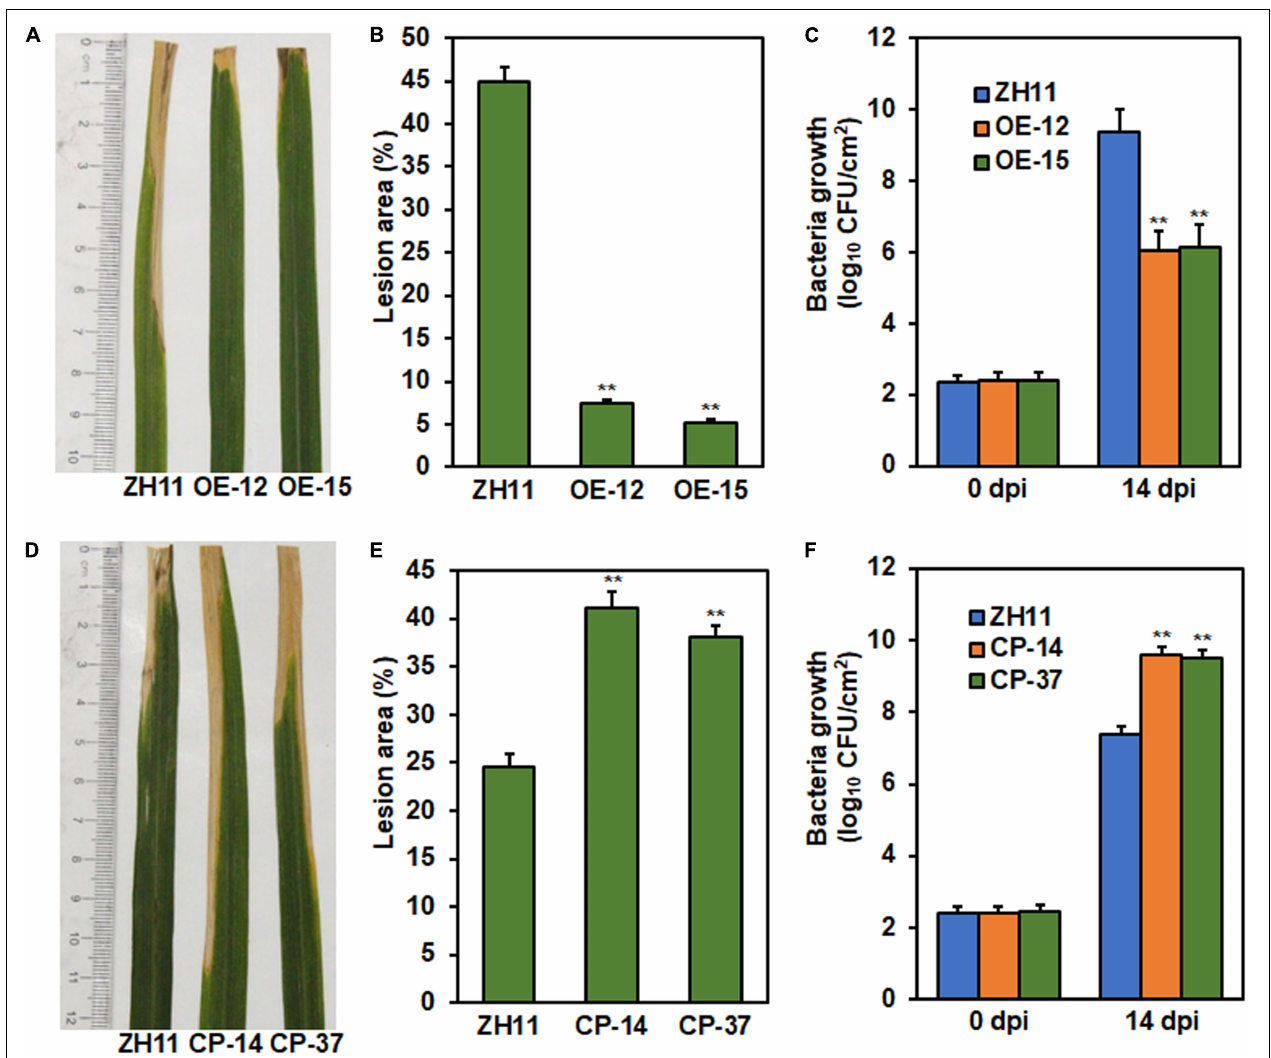
FIGURE 4 | ONAC096 positively regulates rice resistance against Xoo. (A–C) Disease phenotype (A) , lesion area (B) , and bacteria growth (C) in the representative leaves of ONAC096 -OE plants. (D–F) Disease phenotype (D) , lesion area (E) , and bacteria growth (F) in the representative leaves of ONAC096 -CP plants. Rice plants at booting stage were inoculated with bacterial suspension (OD600 = 0.8) by the leaf-clipping method (A,D) . Photographs were taken and leaf samples were harvested at 14 dpi. Bacterial growth was determined by counting the colony-forming units and presented as log 10 (CFU/cm 2 ) (C,F) . Experiments were repeated at least three times with similar results, and results from one representative experiment are shown in panels (A,D) . Data presented (B , C , E,F) are the means ± SE from three independent experiments and asterisks indicate significant difference ( p < 0.01, Student’s t test) in comparison to